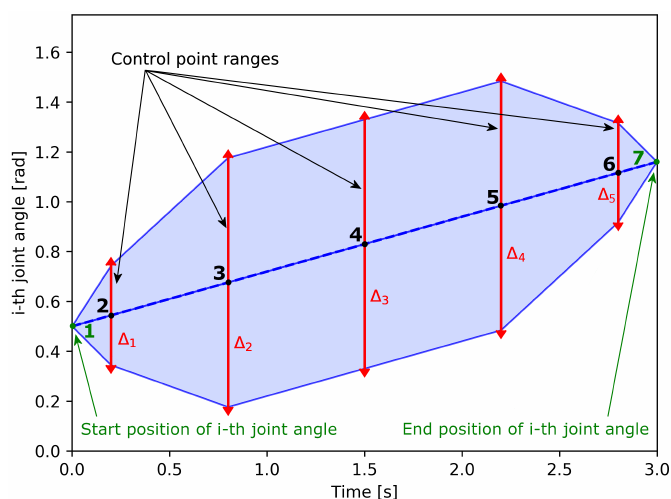
Figure 3. PSO search space for the i-th joint angle. The space is given by Bezier control points in the blue area. The blue area is a convex hull of all admissible PSO trajectories.